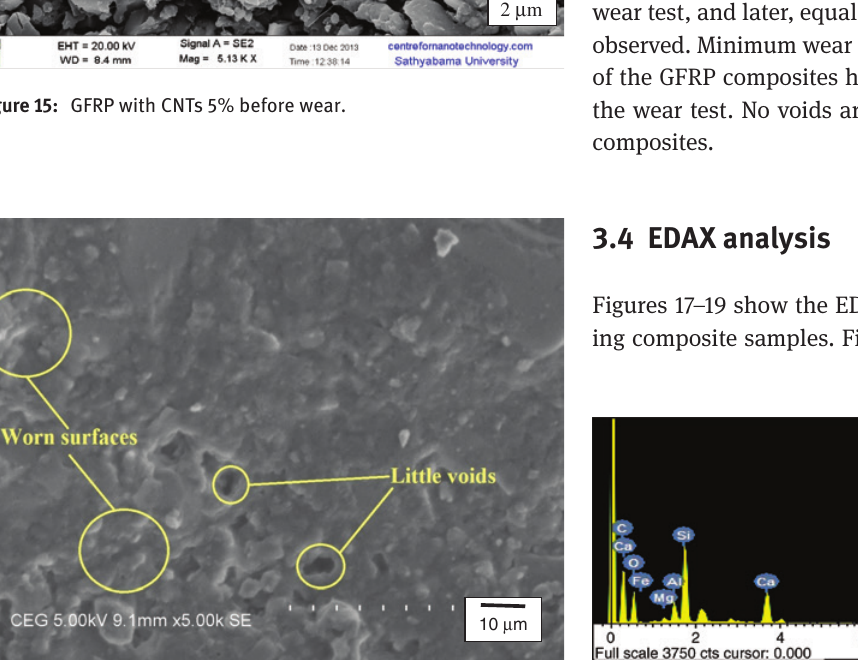
Figure 16: GFRP with CNTs 5% after wear. Figure 17: EDAX report of GFRP composites with 1%